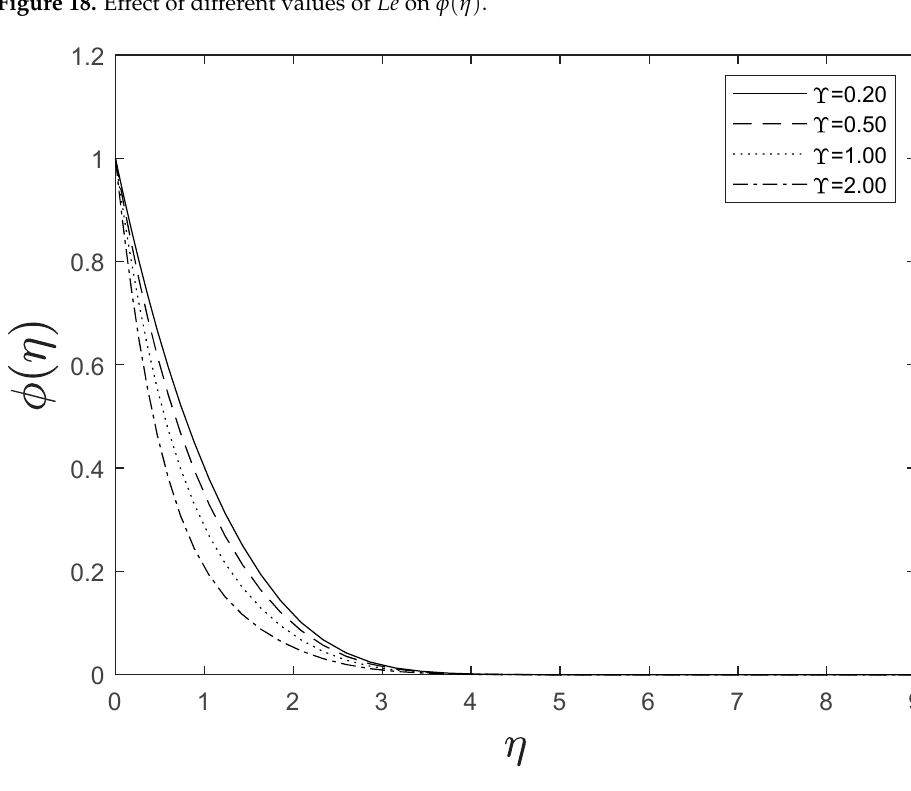
( ) φ η Le on . ( ) φη Le on .